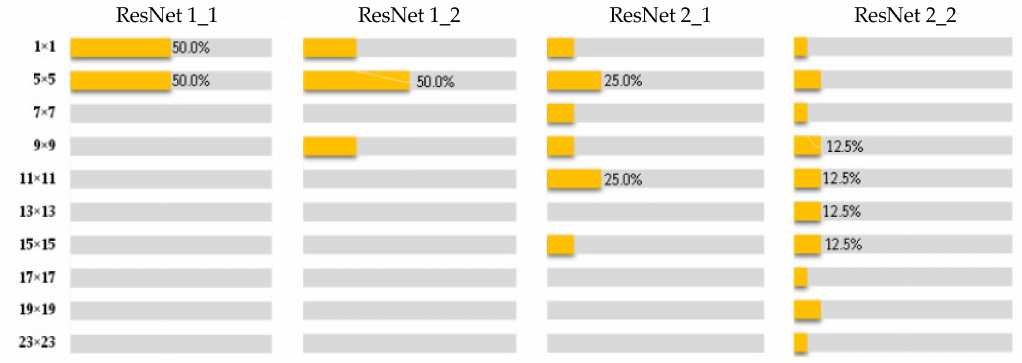
Figure 5. Distribution of the receptive of receptive field of the series structure of two residual